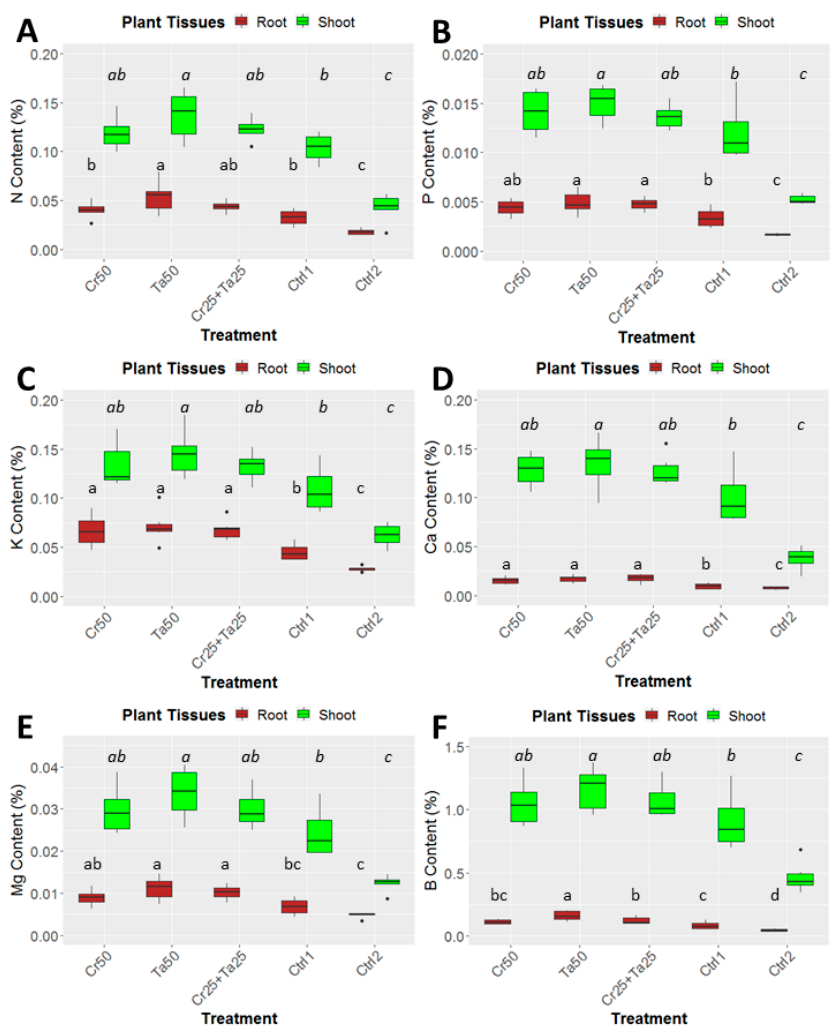
Figure 6. Effects of Ta and Cr, either applied individually or in consortium on the shoot and root nutrient contents in oil-palm seedlings at 5 months post-inoculation (MPI) and nutrients analyzed were ( A ) Nitrogen or N content, ( B ) phosphorus or P content, ( C ) potassium or K content, ( D ) magnesium or Mg content, ( E ) Calcium or Ca content and ( F ) Boron or B concentration. Treatments abbreviations: Cr50—inoculated with 50 g of C. rosea AAB0114 ( Cr ); Ta50—inoculated with 50 g of T. apiculatus AAT0115 ( Ta ); Cr25 + Ta25—inoculated with 25 g of Cr and 25 g of Ta ; control 1—only